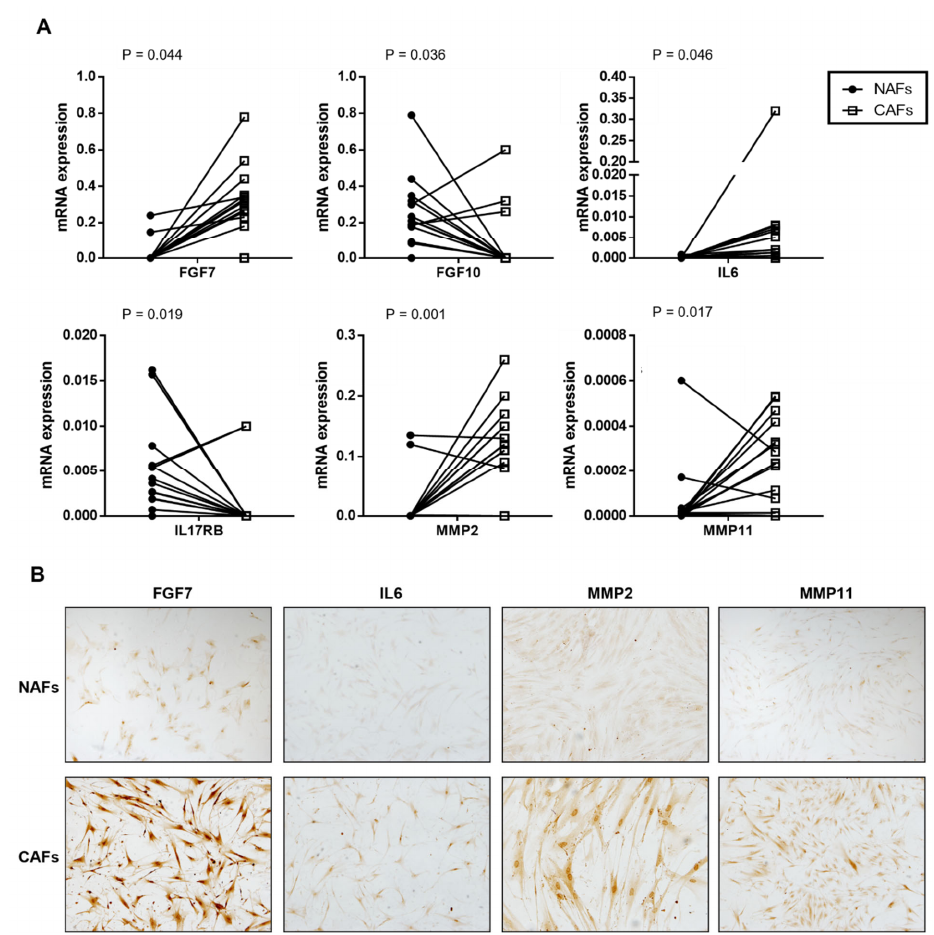
Figure 2. ( A ) Gene expression of stromal factors by CAFs and paired NAFs from 15 prostate carci- nomas. ( B ) FGF7, IL6, MMP2, and MMP11 protein expression of cultured NAFs (upper panel) and CAFs (lower panel).